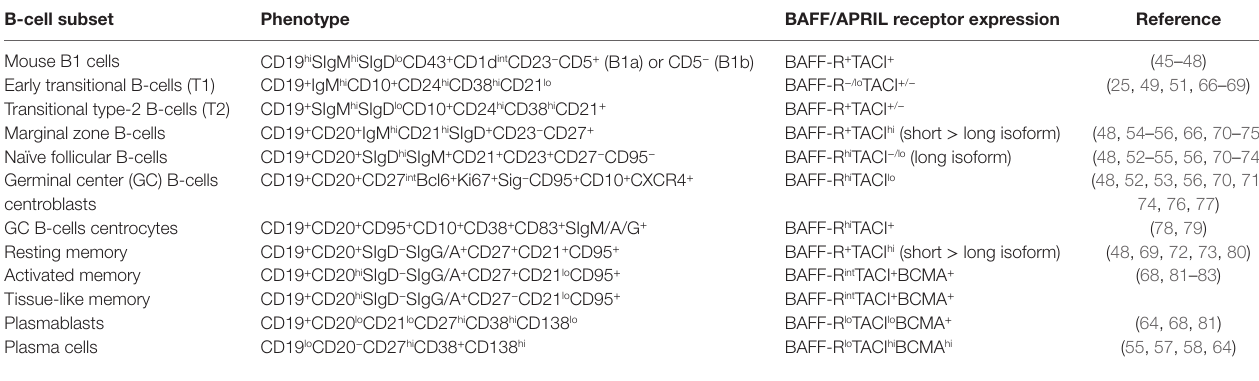
TABle 1 | Phenotype of B-cell subsets and expression of B-cell-activating factor (BAFF)/a proliferation-inducing ligand (APRIL) receptors. B-cell